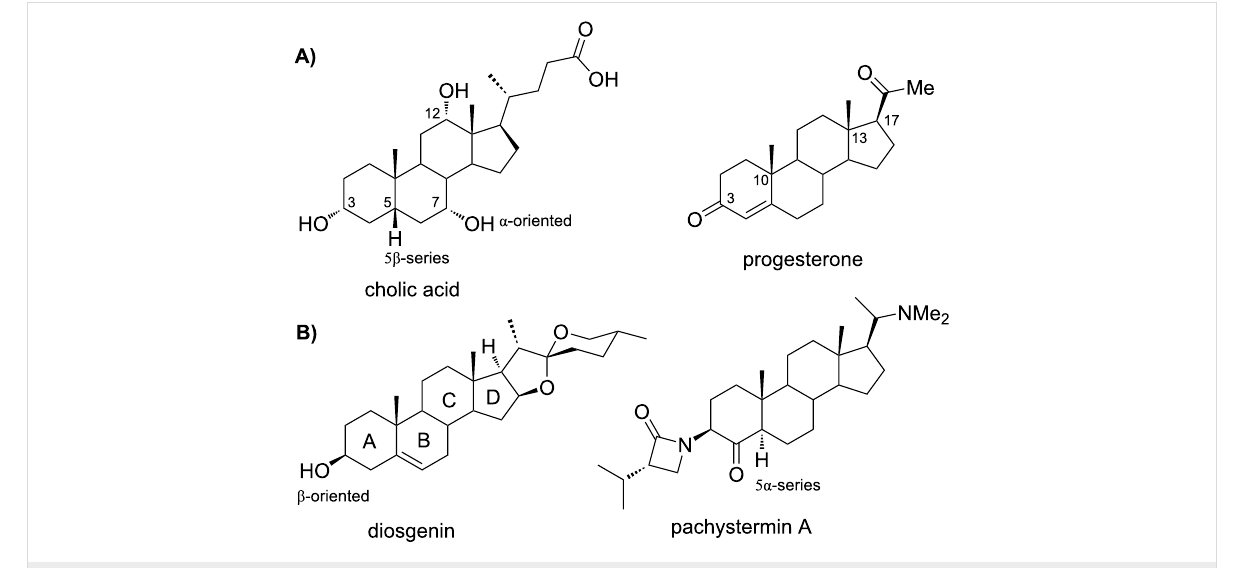
Figure 1: Structures of natural steroids of A) animal and B) plant